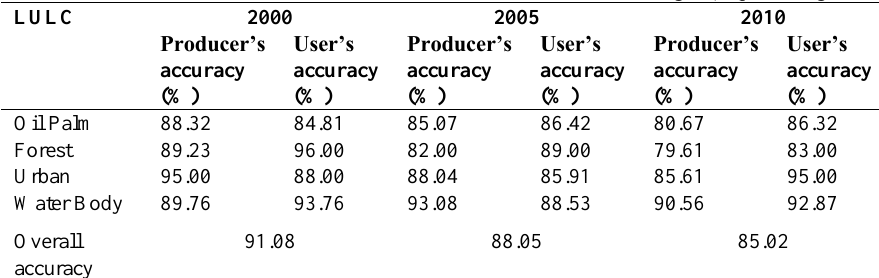
Table. 1: Producer‟s, user‟s and overall accuracies of the classified images (in percentages)